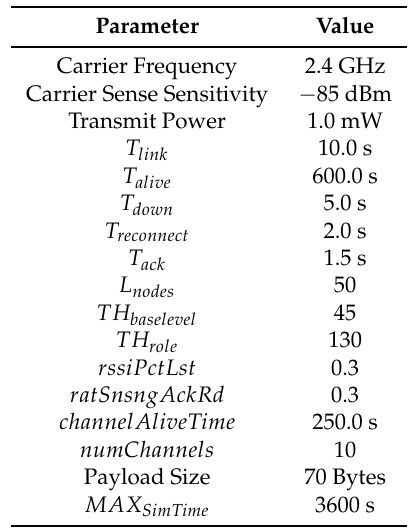
Table 1. Main configuration parameters for the